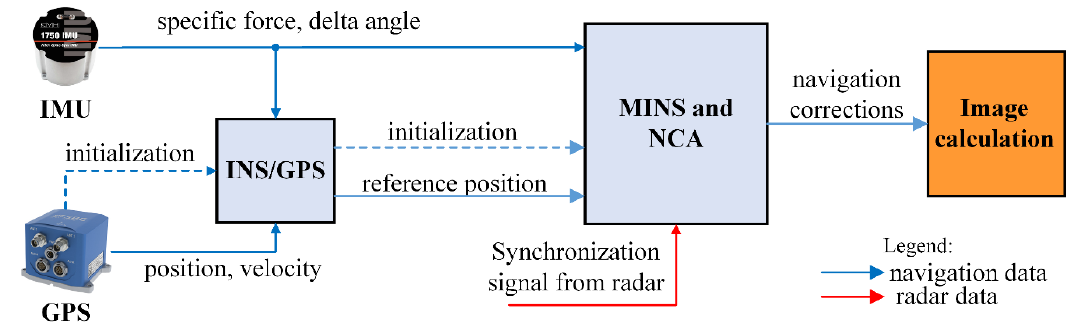
Figure 1. Data flow in multi-instance inertial navigation system (MINS)-based motion correction (MOCO).